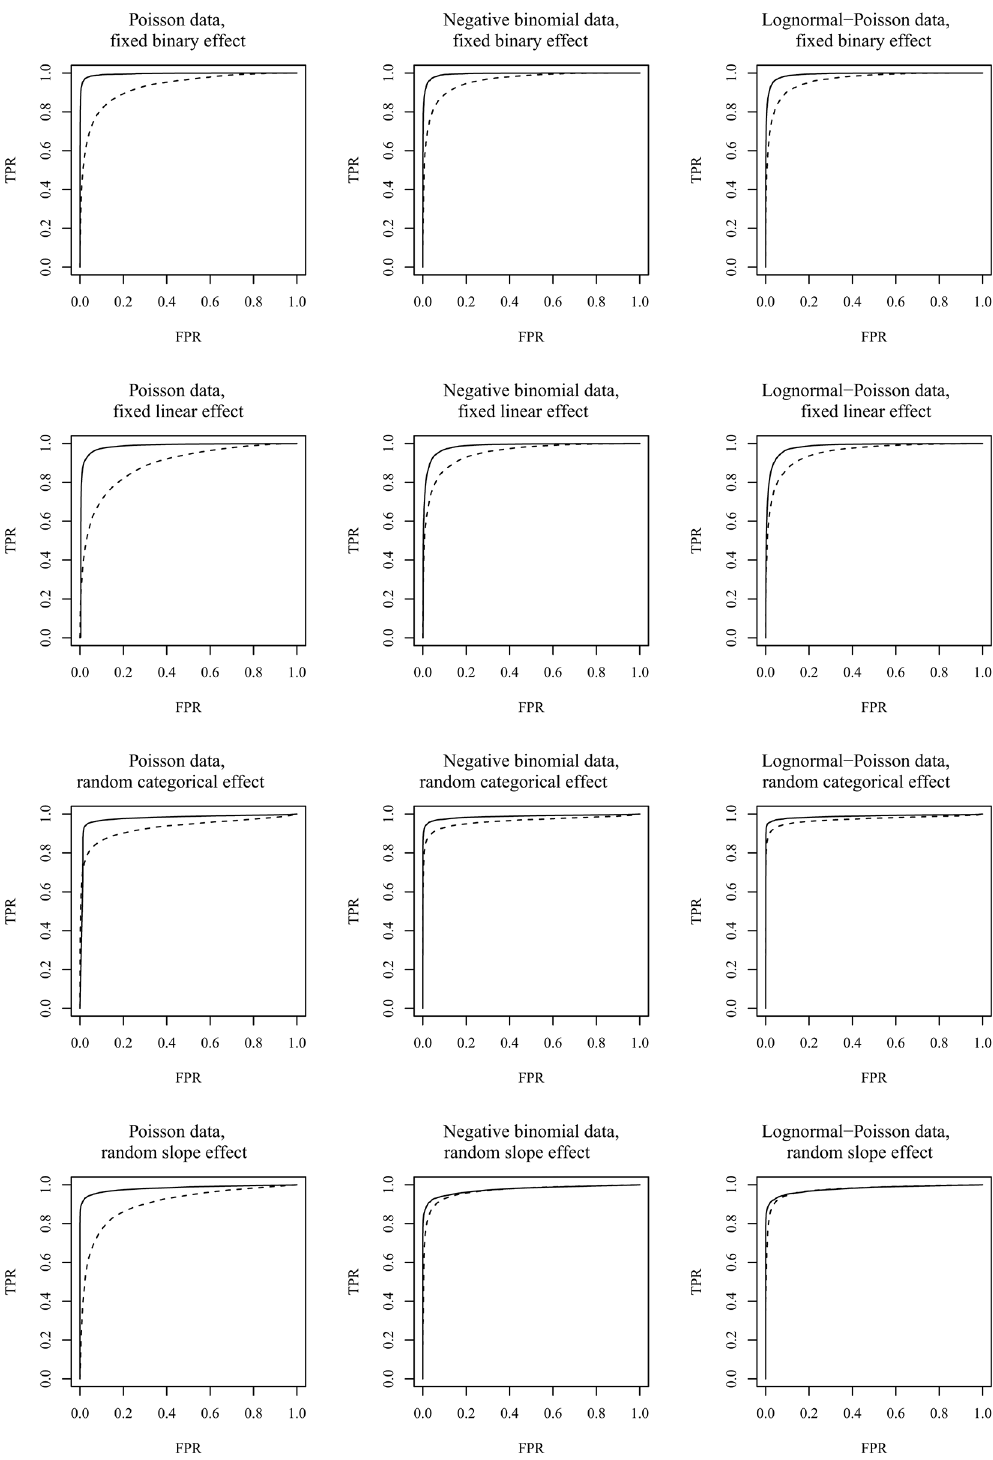
Fig 1. ROC curves (false positive rate against true positive rate) for the different combinations of effect type and data distribution. Solid and dashed lines illustrate the relationship for count data and frequency data respectively.